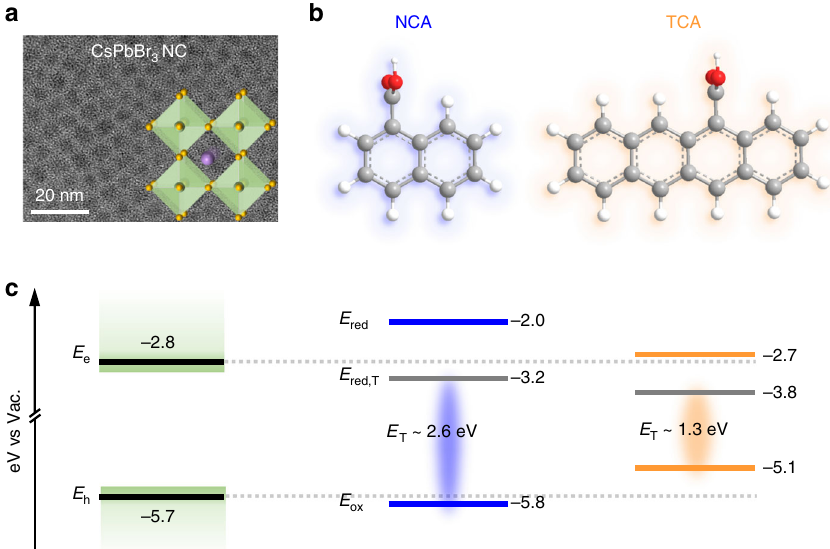
Fig. 1 Design of the NC-PAH systems for TET study. a A representative transmission electron microscopy (TEM) image of the CsPbBr 3 NCs. The scale bar is 20 nm. Inset: a schematic structure of the perovskite lattice. b Molecular structures of the 1-naphthalene carboxylic acid (NCA) and 5-tetracene carboxylic acid (TCA). c Schematic energy level alignment between NCs and NCA and TCA determined from cyclic voltammogram. E e and E h are the lowest electron and hole energy levels in the conduction and valence bands, respectively. The difference between them is ~2.9 eV, which is higher than the optical gap of the NCs (~2.7 eV) because of a strong electron-hole coulomb binding energy in NCs. E ox , E red and E red,T are the ground-state oxidation potential energy, reduction potential energy and triplet state reduction potential energy, respectively, of the PAH molecules. E T is the triplet